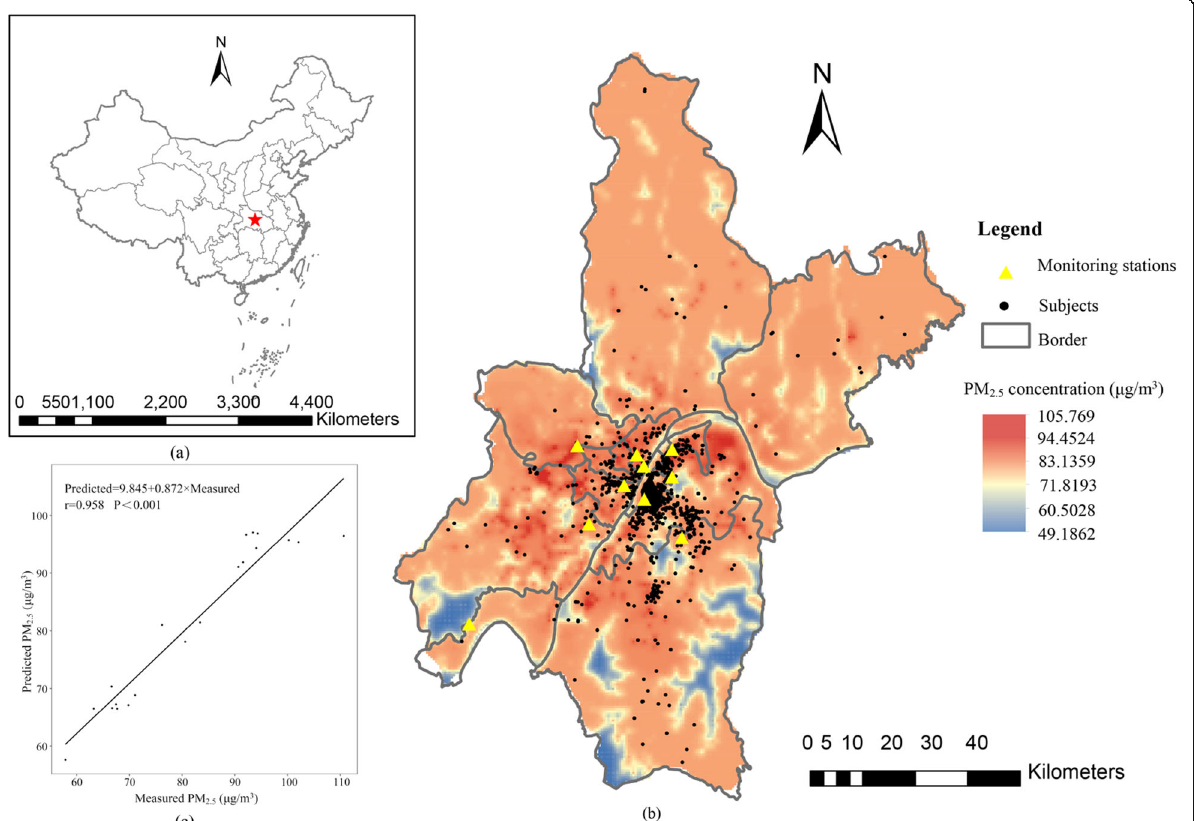
Fig. 2 Geographical location of Wuhan in China ( a ). Spatial distribution of mean PM 2.5 estimations across Wuhan city from January 1, 2013 to August 31, 2015 ( b ). A scatter plot correlating the measured and predicted PM 2.5 values from 10 monitoring stations ( c